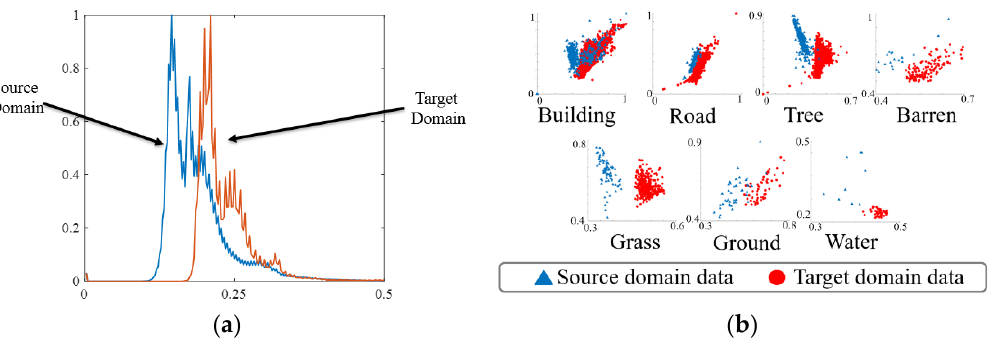
Figure 3. An intuitive visualization of typical domain gaps and misalignment of feature distributions between the source and target domain: ( a ) Marginal distribution (feature distribution over all the classes) of radiometric values; ( b ) conditional distribution of a typical two-dimensional feature of the two domains showing the misalignment on different object classes, x and y axis of these subfigures plots are appropriately adjusted for best visualization.